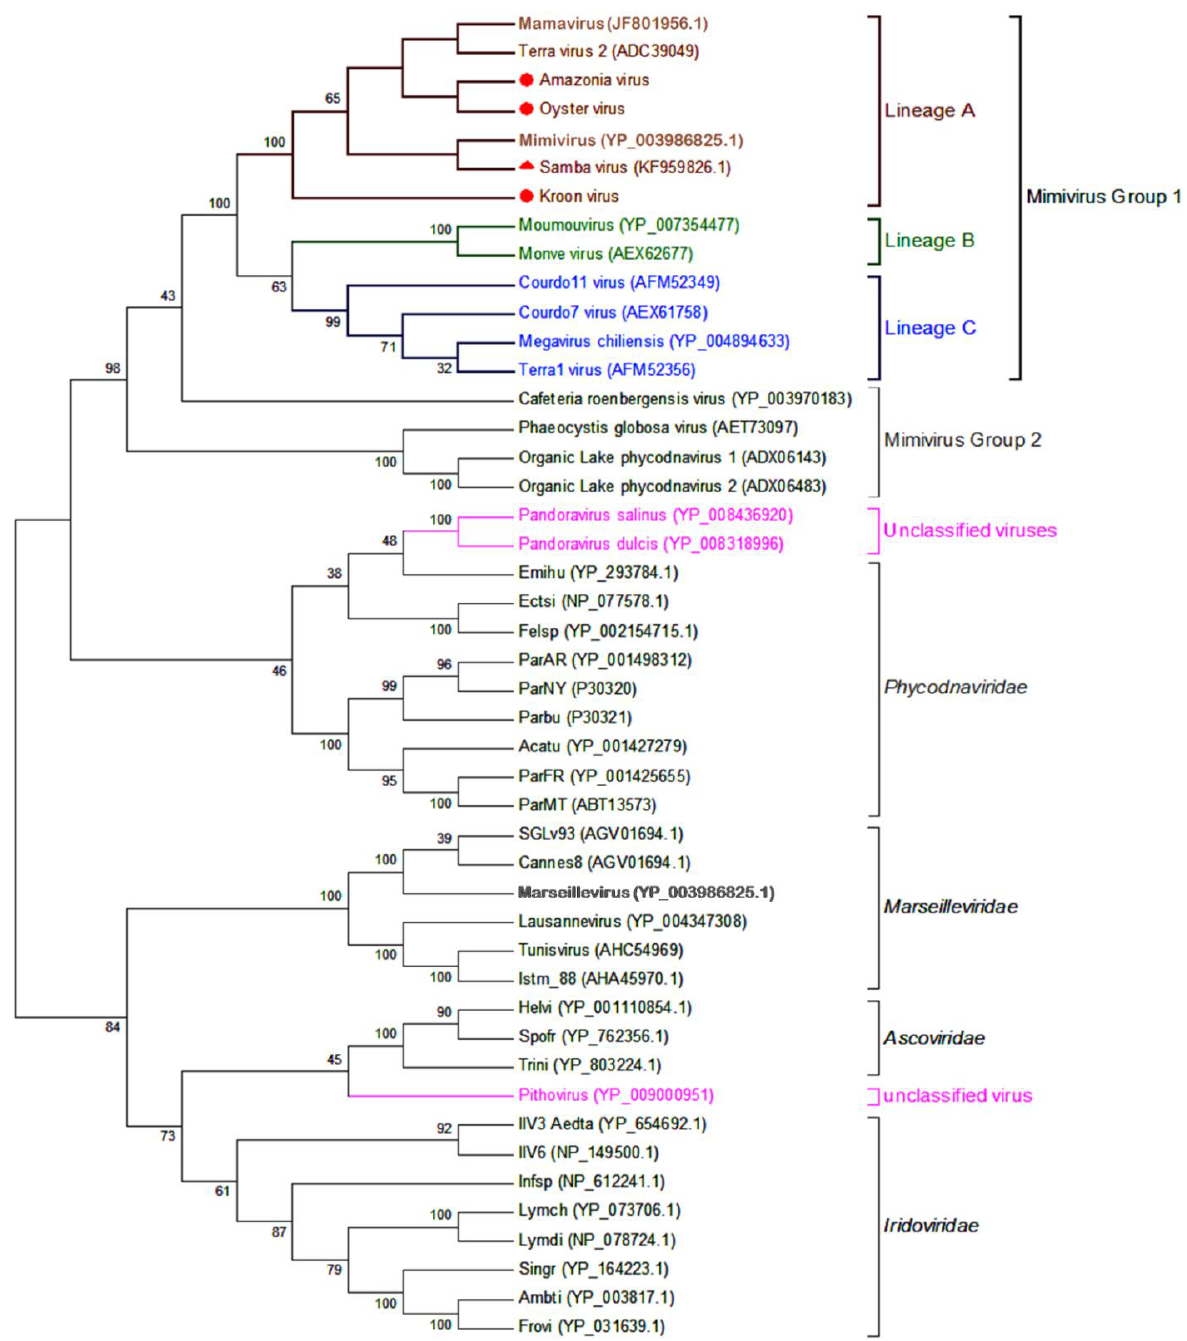
Figure 6. Phylogenetic reconstruction of Brazilian mimiviruses and other megaviruses based on family B DNA polymerase. A phylogenetic tree was generated using MEGA5 software with the Maximum likelihood method. The percentage of trees using 1000 bootstrap replicates in which the associated taxa clustered together is shown next to the branches. Brazilian mimiviruses, highlighted by red markers, are clustered with members of lineage A amoebal mimiviruses. The circles indicate new viruses; the triangle indicates the previously reported Brazilian mimivirus. For each sequence, the GenBank gene identification numbers are indicated. The branches were identified by brackets and family names. Branches corresponding to lineages of amoebal mimiviruses are differentiated by colors. Currently unclassified viruses are highlighted in pink.